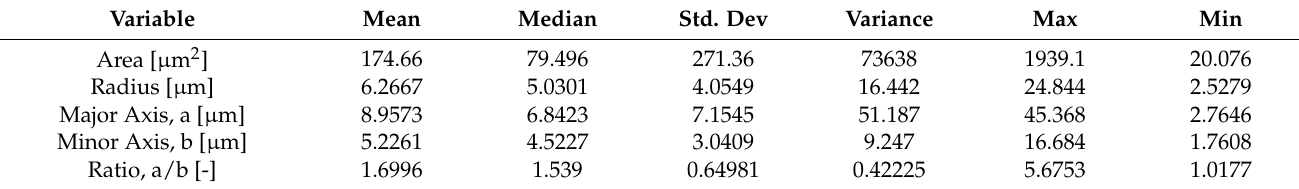
Table 17. Void data for Plate 2.